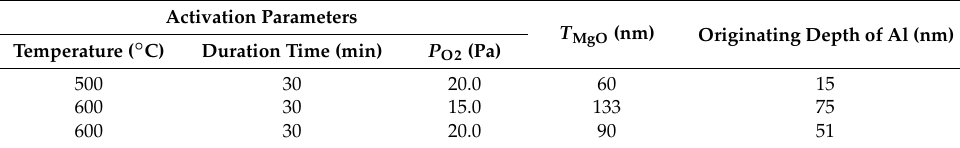
Table 1. The thickness of the MgO film (T MgO ) and the depth at which Al originates in the surface film of the Ag-2Mg-2Al specimens activated at different temperatures and oxygen